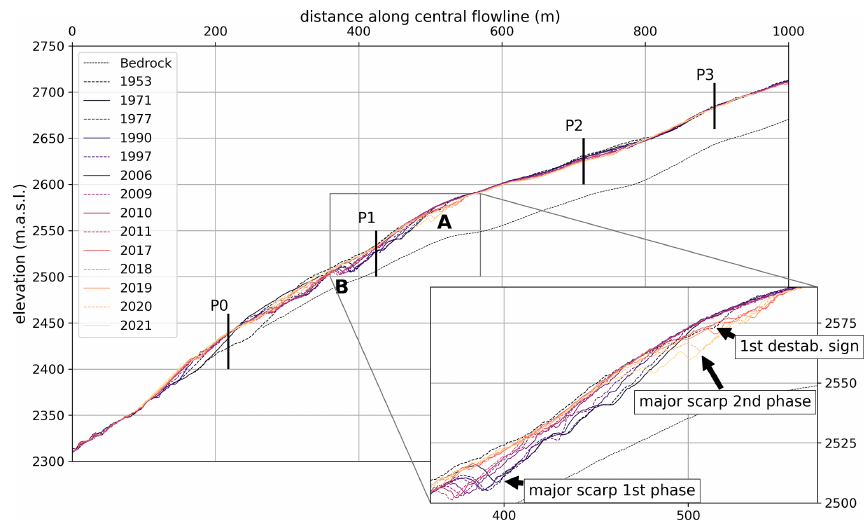
Figure 8. Surface elevation along the flowline as extracted from the DSMs. Estimated bedrock profile (dashed line) from Hartl et al. (2016b). Annotations show positions of the cross profiles. A and B mark upper and lower zones of morphological destabilization signs, as in Fig.